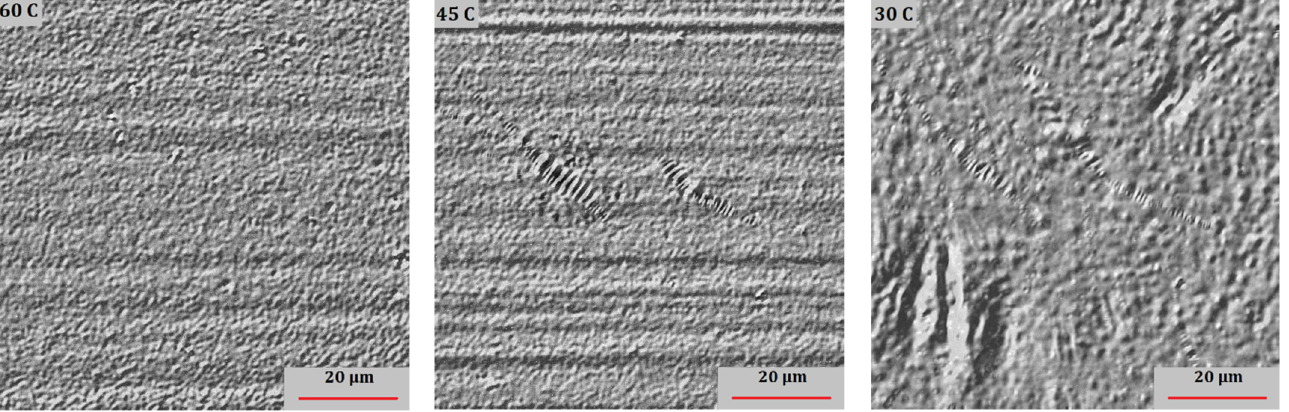
Figure 7. CLSM-DIC images of bitumen A at selected temperatures during the fast cooling scan (1.25 °C/min).